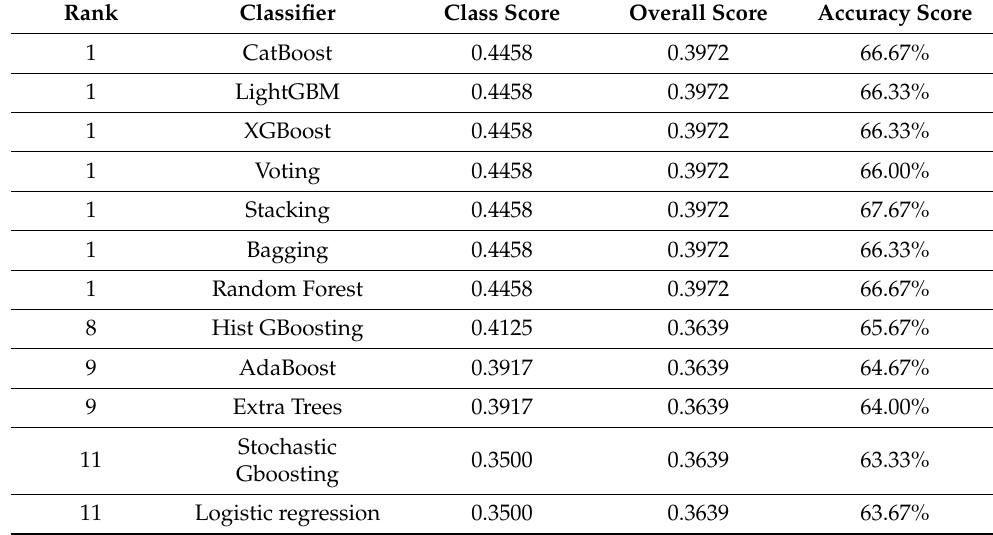
Table 8. Ranking of the